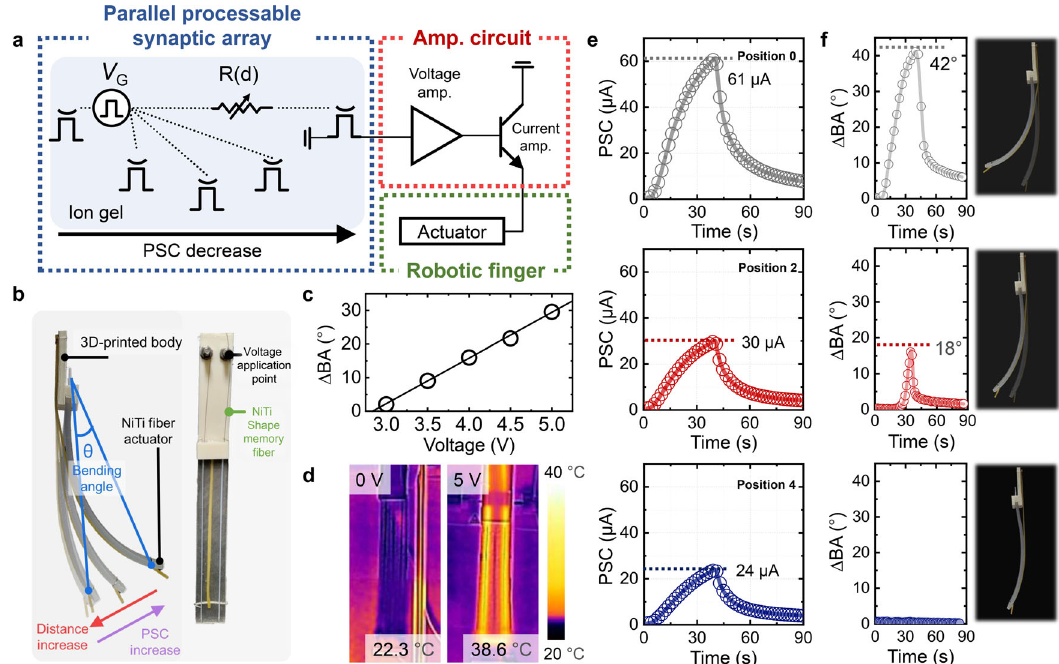
Fig. 3 | Characterization of robotic fi nger control with the PPSA. a Circuit dia- gram of the robotic fi nger actuation system. b Photographs of the fabricated robotic hand and its components. c Change in the BA of a robotic fi nger with increasing appliedvoltage onthe robotic fi nger (3.0 – 5.0V). d Thermal images of a